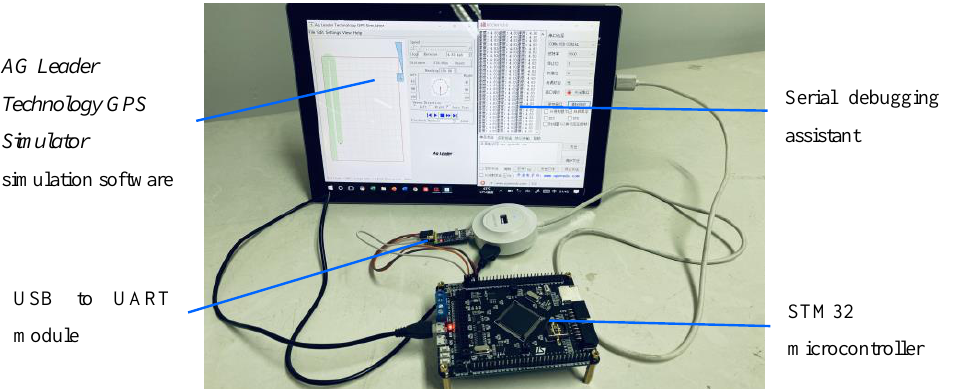
Figure 3. GNSS receiver speed signal simulation.